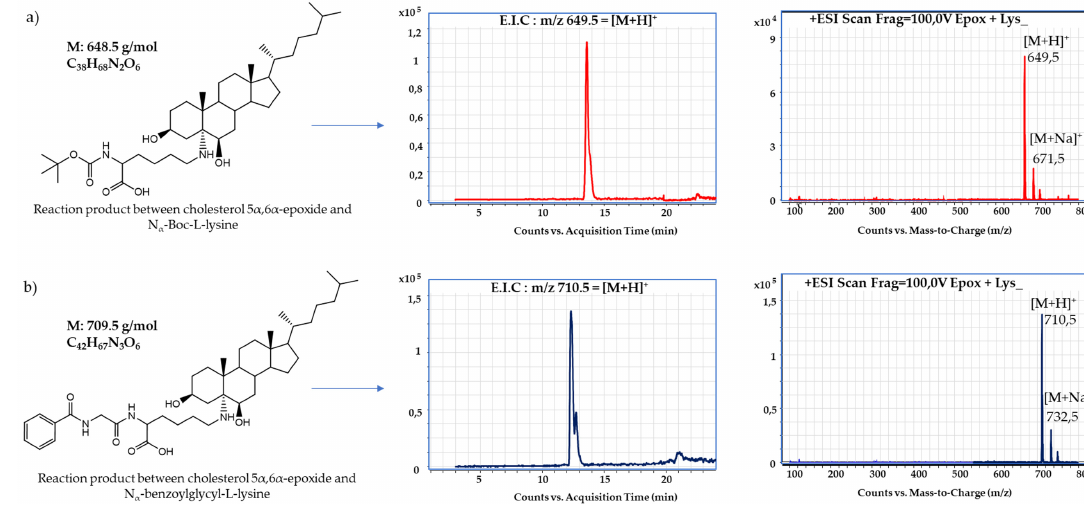
Figure 4. Molecular ions and respective mass spectra of products from reaction mixtures between ( a ) cholesterol 5 α ,6 α -epoxide and N α -Boc- L -lysine; ( b ) cholesterol 5 α ,6 α -epoxide and N α -benzoylglycyl- L -lysine. E.I.C: Extract ion chromatogram. ESI: Electrospray ionization.